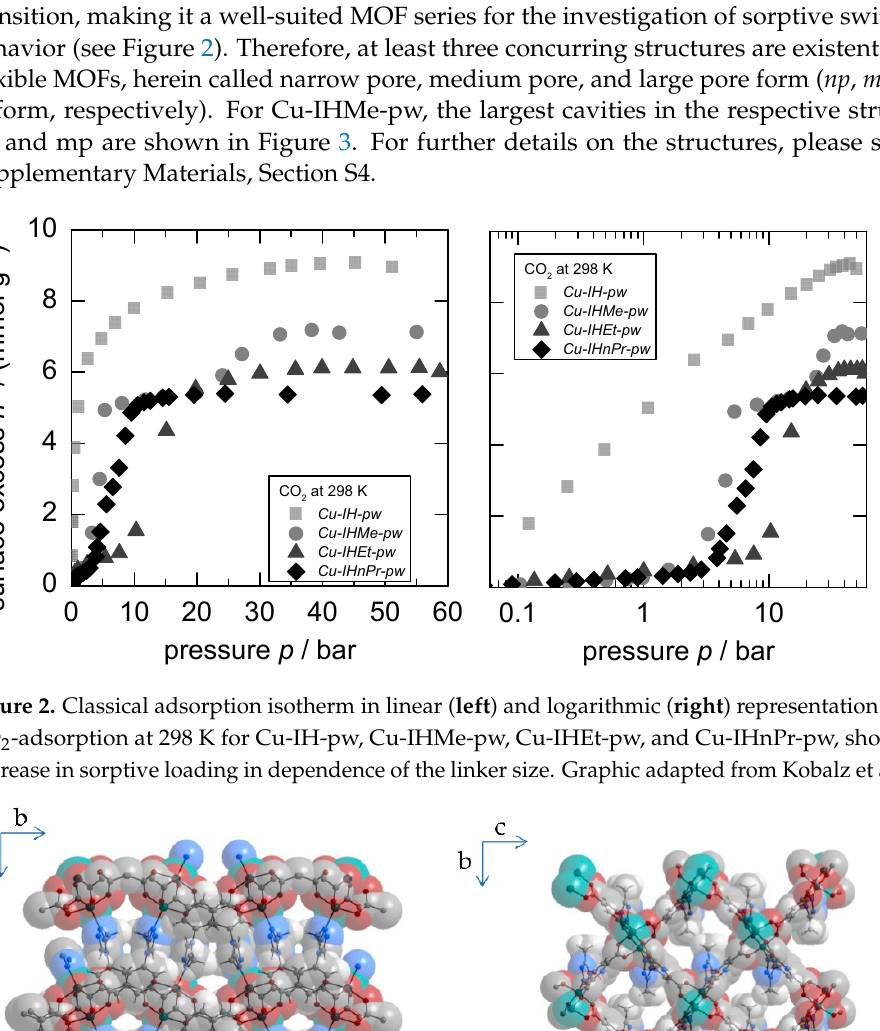
Figure 1. Illustration of organic linkers for the MOFs Cu-IH-pw , Cu-IHMe-pw , Cu-IHEt-pw , and Cu-IHnPr-pw from left to right. The differences are within the alkyl side-chain in the 2-position of the triazolyl ring.